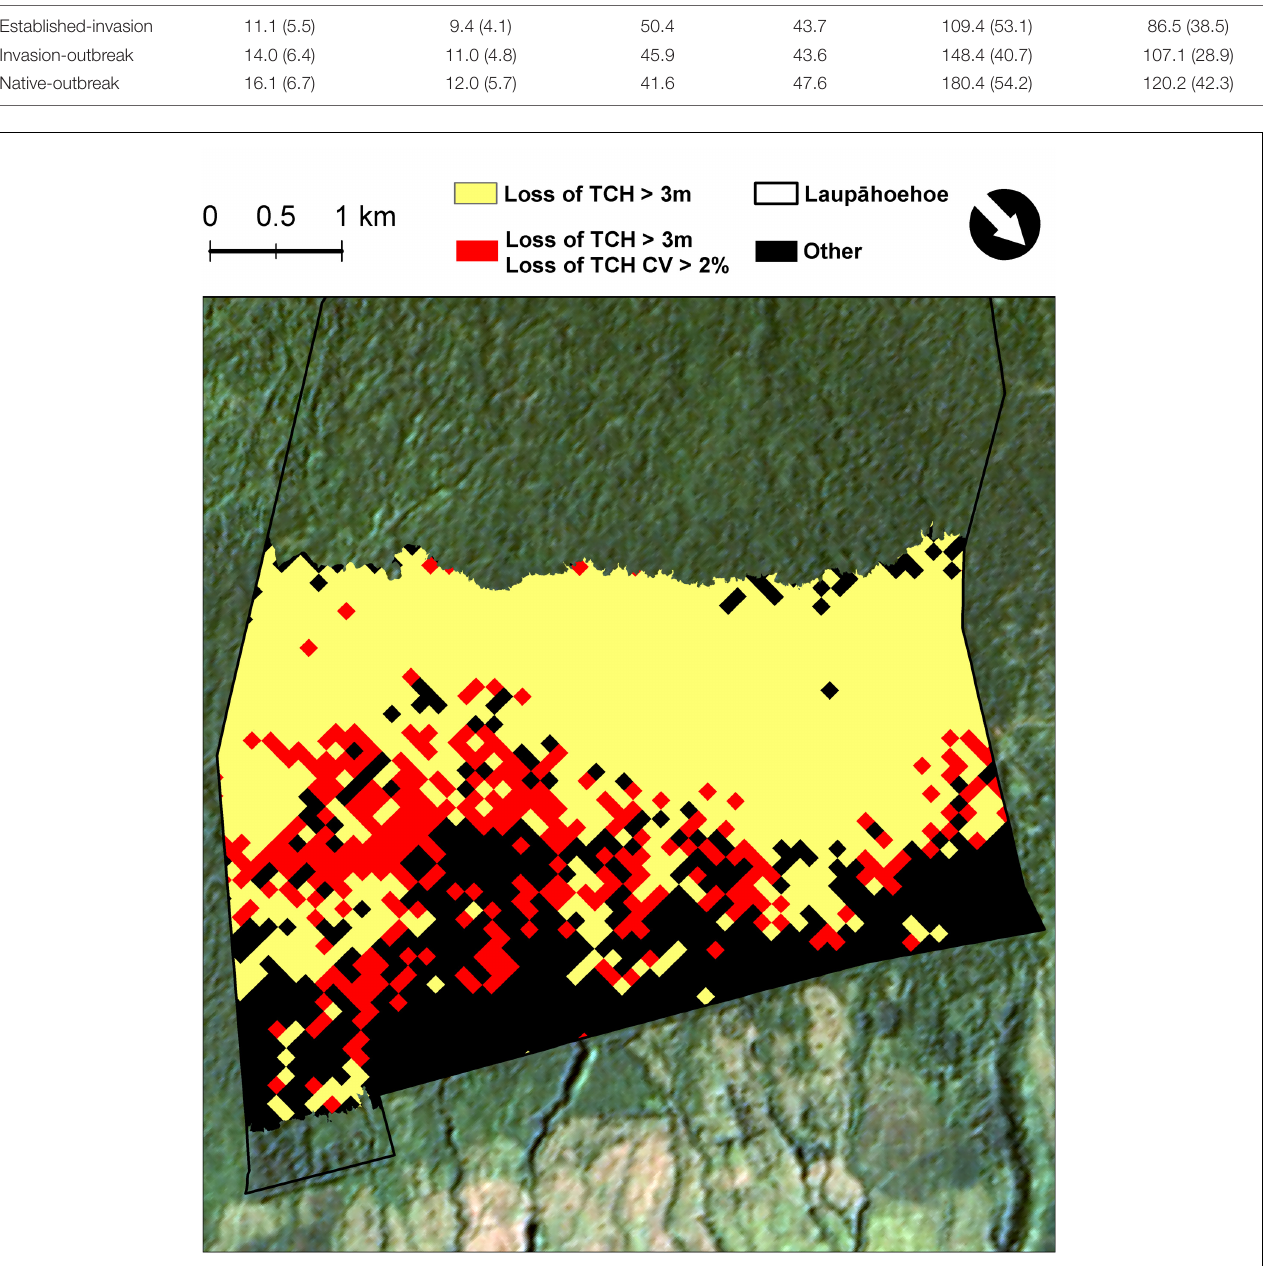
FIGURE 4 | Map highlighting the transition zone (red) between highly invaded and native dominated forests, based on top-of-canopy height (TCH), decreasing and becoming less complex. Forests on a per hectare basis that have experienced a net loss in median TCH > 3 m (yellow) and a minimum decrease in TCH variation of 2% (red) from 2007 to 2016. Black areas did not experience a decrease in median TCH > 3